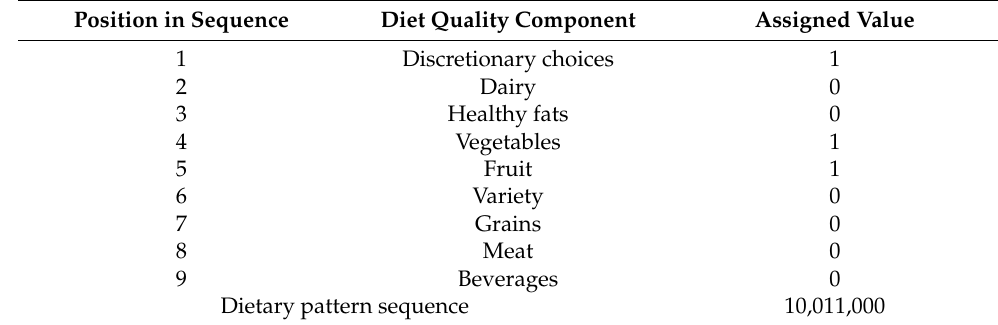
Table 1. Example of a nine-digit sequence of low (value = 1) and high (value = 0) component scores within an individual’s dietary guideline index